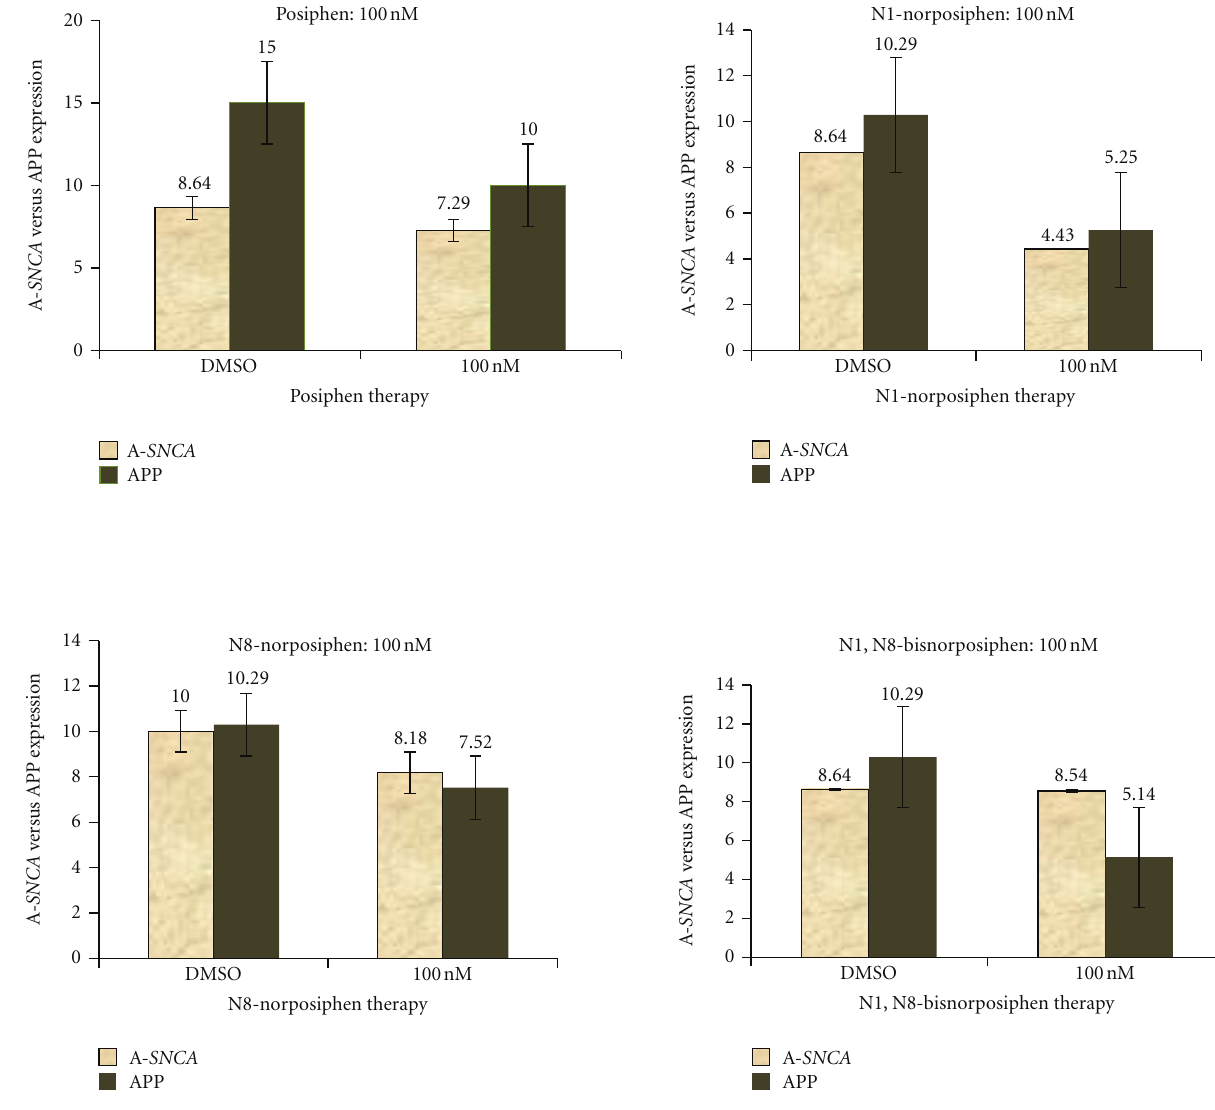
Figure 6: Percent inhibition of α - synuclein/APP by posiphen compared with its metabolic analogs in primary E18 neurons (from PAC- Tg( SNCA ) mice). Densitometry and quantitation of the relative levels α - synuclei n /APP from western blots ( β -actin standardized) after treating primary neurons with posiphen and each of its three metabolic analogs at 100nM concentration for 48 hours.